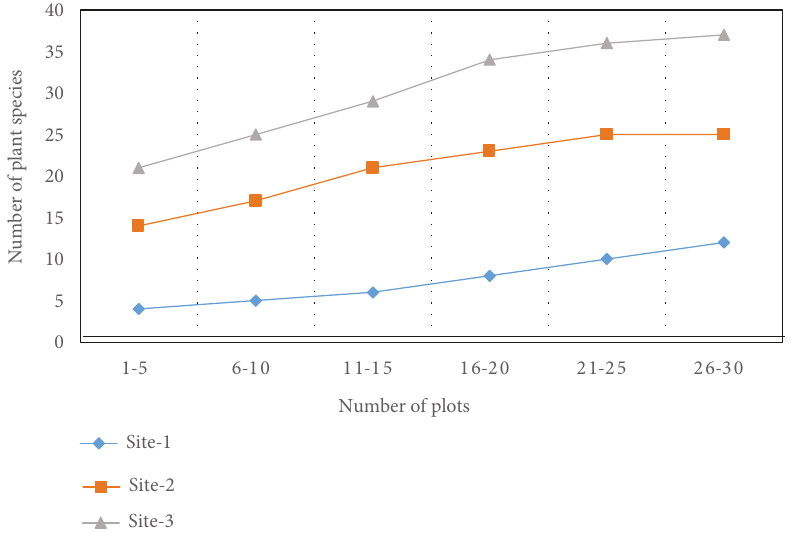
Figure 4: Species richness-area curves for all three distance sites in the Bhawal Sal forest.